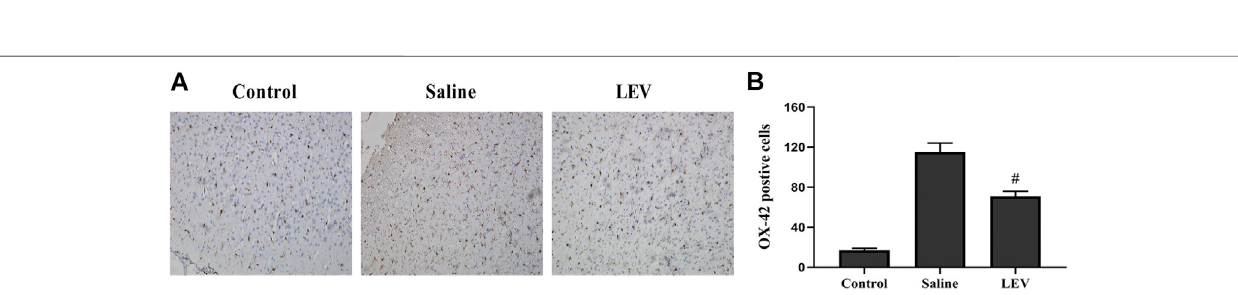
FIGURE 4 | Levetiracetam (LEV) treatment improved neurological function recovery and attenuated behavioral defects after middle cerebral artery occlusion (MCAO)-inducedcerebralinfarction.Thewatermazetaskandrotarodtestwereusedforevaluation. (A) LEVsigni fi cantlyshortenedthetimerequiredforratstoreachthe platform in the water maze task. (B) LEV markedly increased the retention time of MCAO rats on an accelerating rotarod on days 7 and 14 after ischemia. N (cid:1) 12 per group. * p < 0.05; ** p < 0.01 LEV group vs. saline group; ## p < 0.01 compared to the control group.